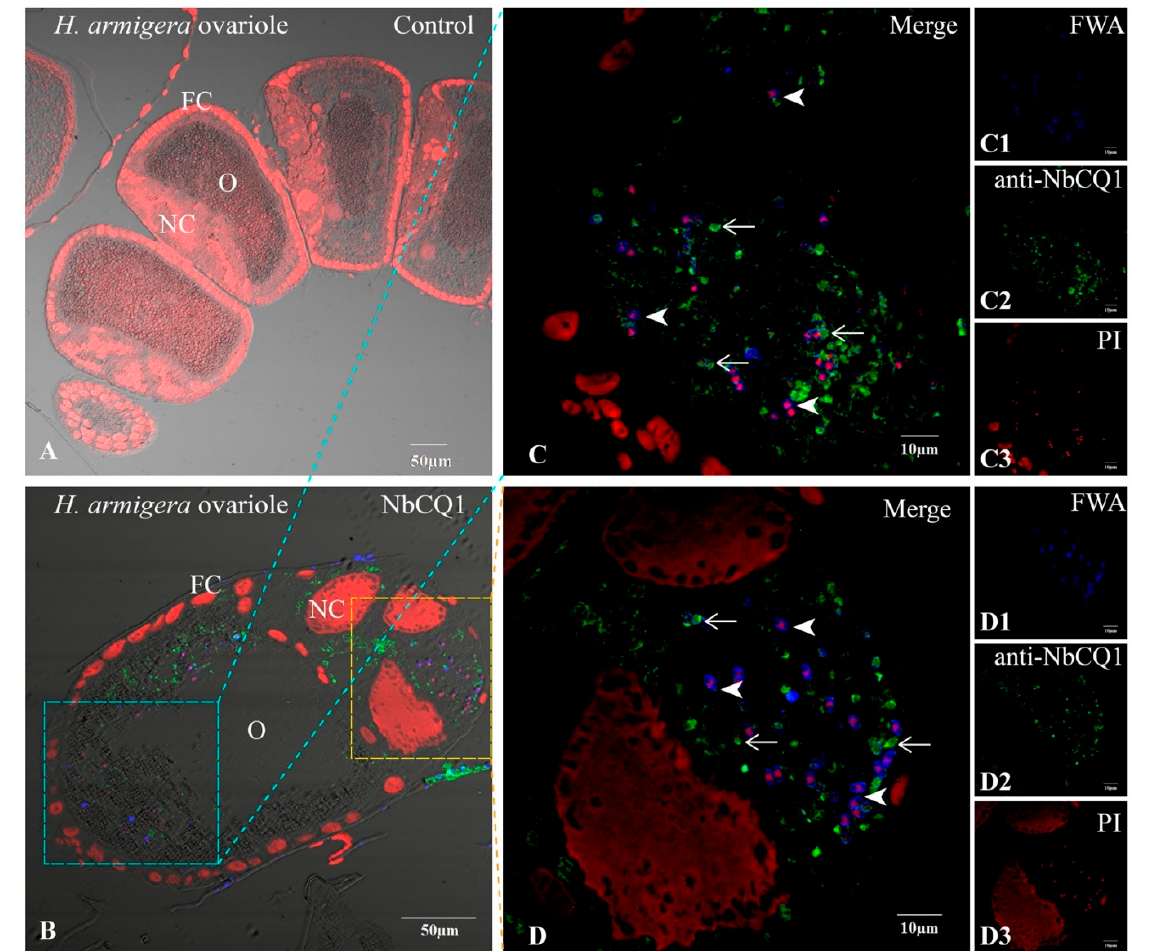
Figure 4. Paraffin sections of H. armigera ovariole infected by NbCQ1. ( A ) Uninfected ovariole; ( B ) Infected ovariole; ( C ) An enlarged view of the infection of oocyte; ( D ) An enlarged view of the infection of follicle cell; ( C1 , D1 ) NbCQ1 spores stained with FWA; ( C2 , D2 ) Proliferative NbCQ1 labeled with antibody; ( C3 , D3 ) Nucleus stained by PI. FC: follicle cell; O: oocyte; NC: nurse cell; Arrowhead shows mature spores; Arrow shows parasites in proliferation.